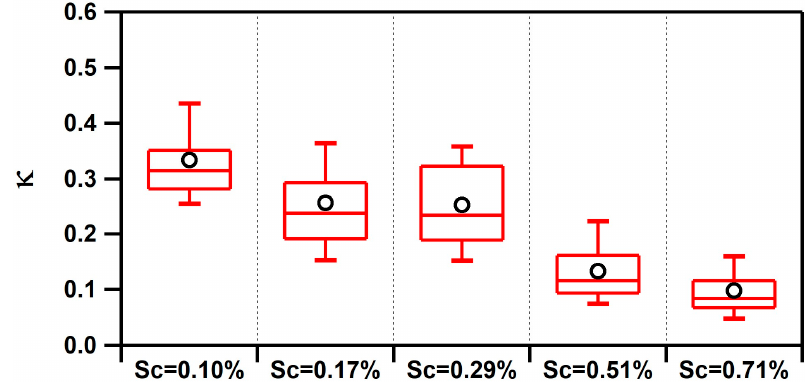
Figure 3. Box and whisker plots of κ values calculated at different values of S crit (S c ). Average values are denoted by black circles.